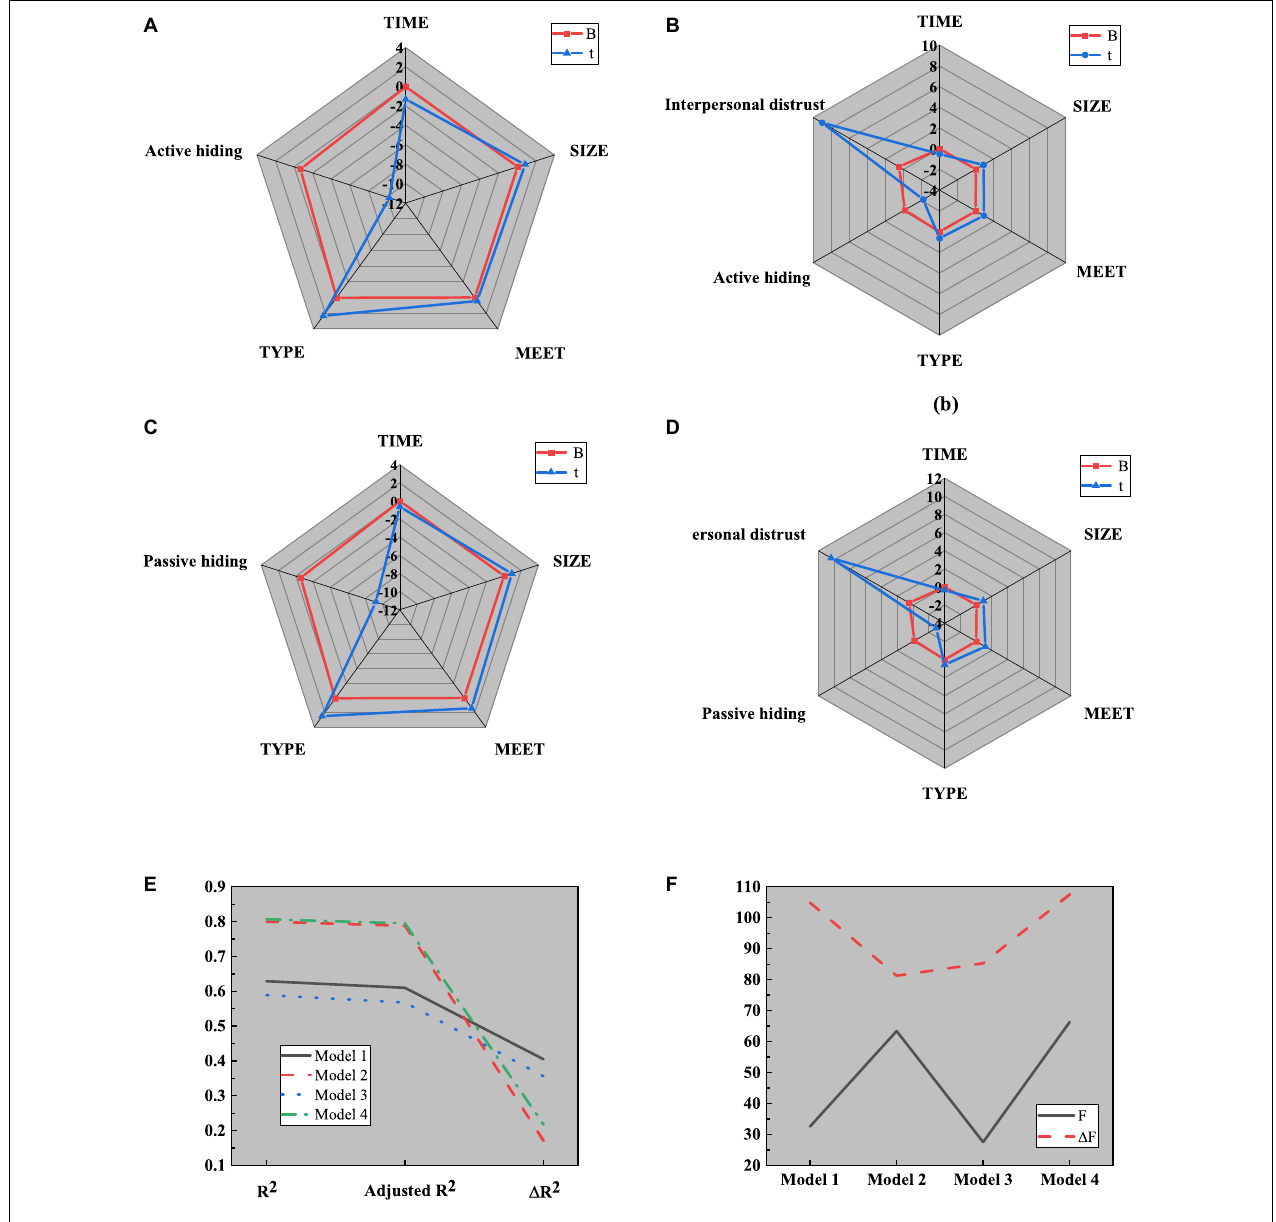
FIGURE 14 | Regression analysis of the mediating role of interpersonal mistrust between active hiding, passive hiding, and temporary team performance. (A) Regression model 3; (B) Regression model 4; (C) Regression model 5; (D) Regression model 6; (E) Parameters of R 2 ; (F) Parameters of